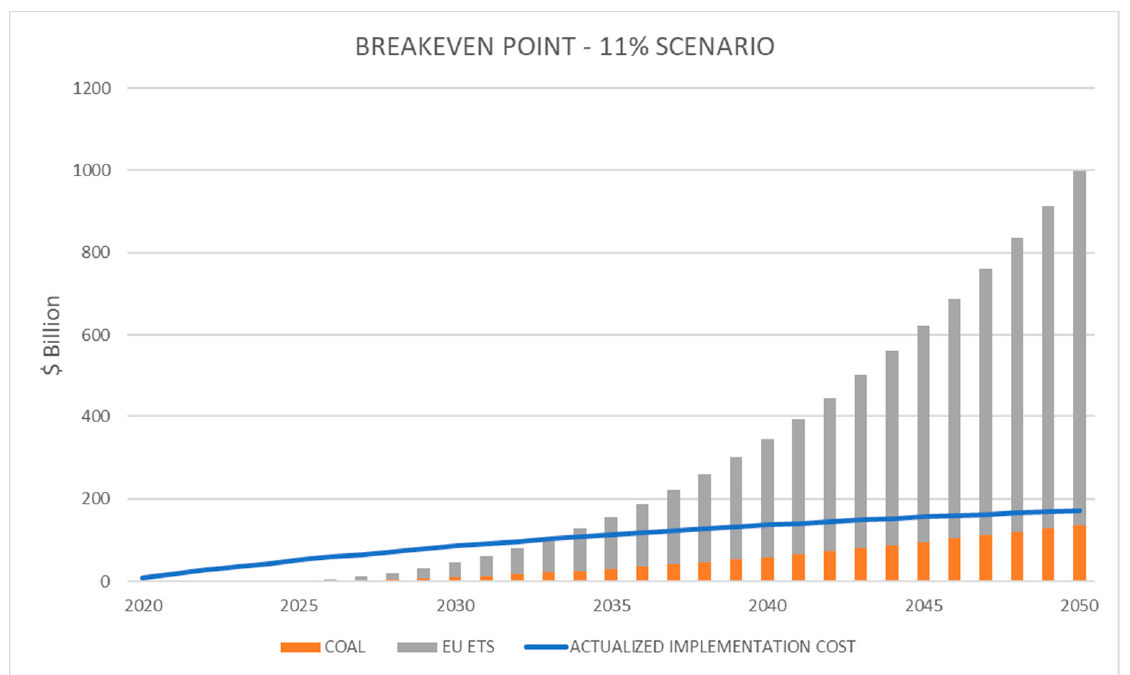
Figure 11. Payback period in the 11% scenario.